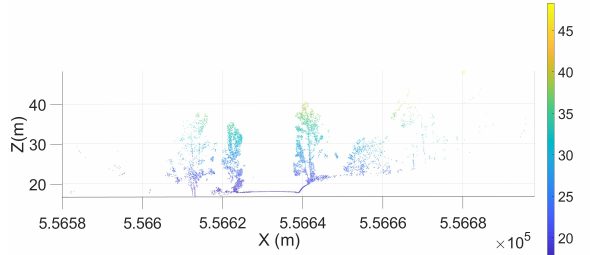
Figure 6. Slice example of 1 meter of length of road. Tree vegetation can be easily identified.